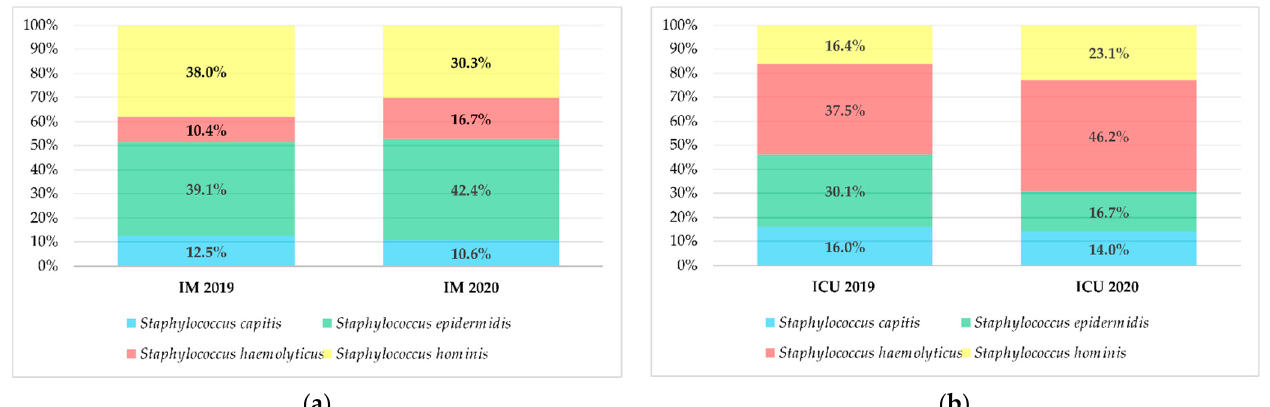
Figure 7. Distribution of the four major species of blood culture contaminants in 2019 and 2020 in the: ( a ) Internal Medicine (IM) department, ( b ) and Intensive Care Unit (ICU).